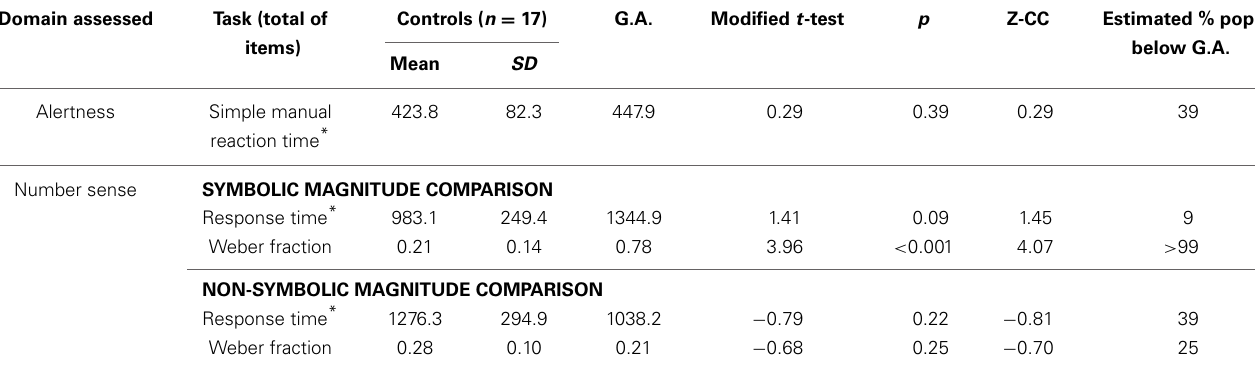
Table 4 | Descriptive data and comparison between control groups and G.A. in the alertness and number sense tasks. Domain